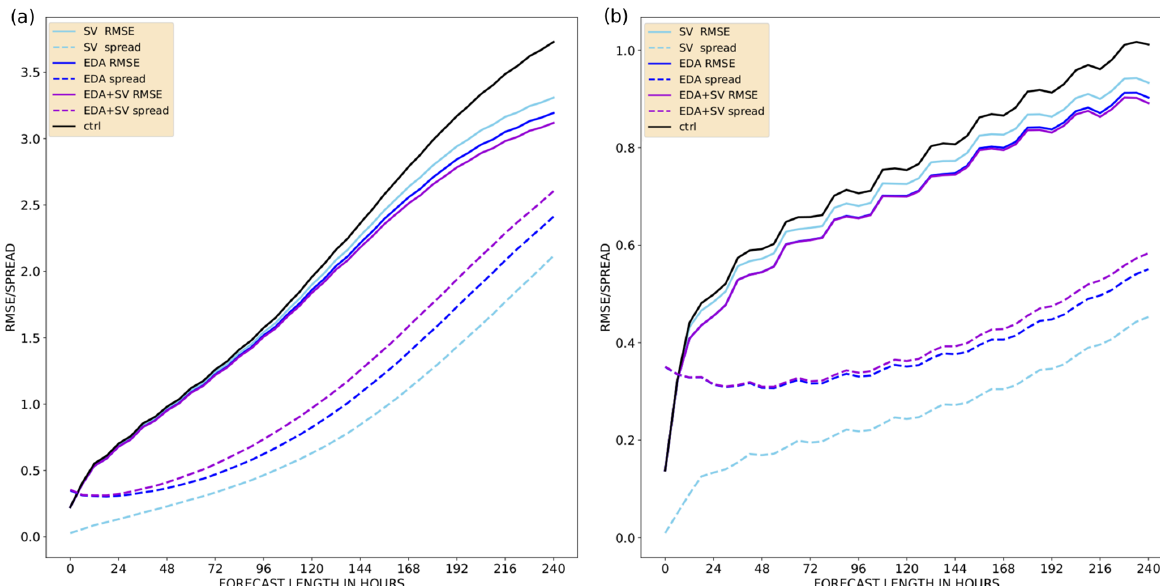
Figure 1. Ensemble mean RMSE (solid) and ensemble spread (dashed) of temperature at 850hPa as a function of forecast lead time up to 240h for a T L 159 model resolution with 50 ensemble members. The mean is calculated over 46 start dates. The experiments included are as follows: only SV perturbations (cyan), only EDA perturbations (blue), and both SV and EDA perturbations (violet). Also shown here is the unperturbed control member RMSE (black). Panel (a) shows the Northern Hemisphere, and panel (b) shows the